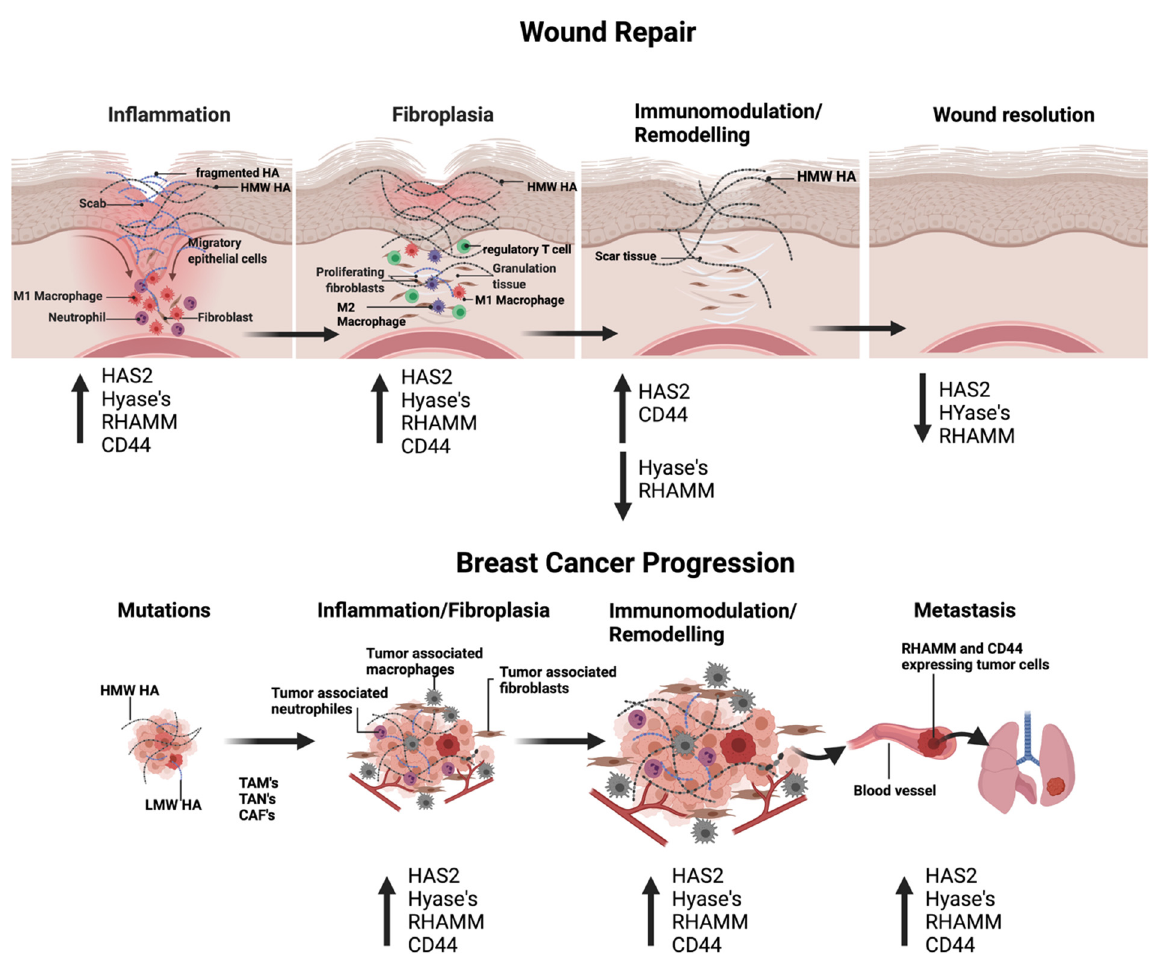
Figure 3. HA polymers, CD44 and RHAMM, regulate wound repair and promote breast cancer progression. During early stages of wound repair and during breast tumor progression, expression of HAS2, Hyal’s, CD44 and RHAMM is upregulated, providing optimal conditions for infiltration of immune cells and cell proliferation. During later stages of wound repair, Hyal and RHAMM expression is reduced, resulting in a prevalence of HMW HA and signaling via CD44. At the final stage of wound repair, HA production and HA receptor expression return to levels seen in unwounded skin. In contrast, HA synthesis, fragmentation and HA receptor expression remain high throughout breast cancer progression. Created with BioRender.com (accessed on 12 September 2021).